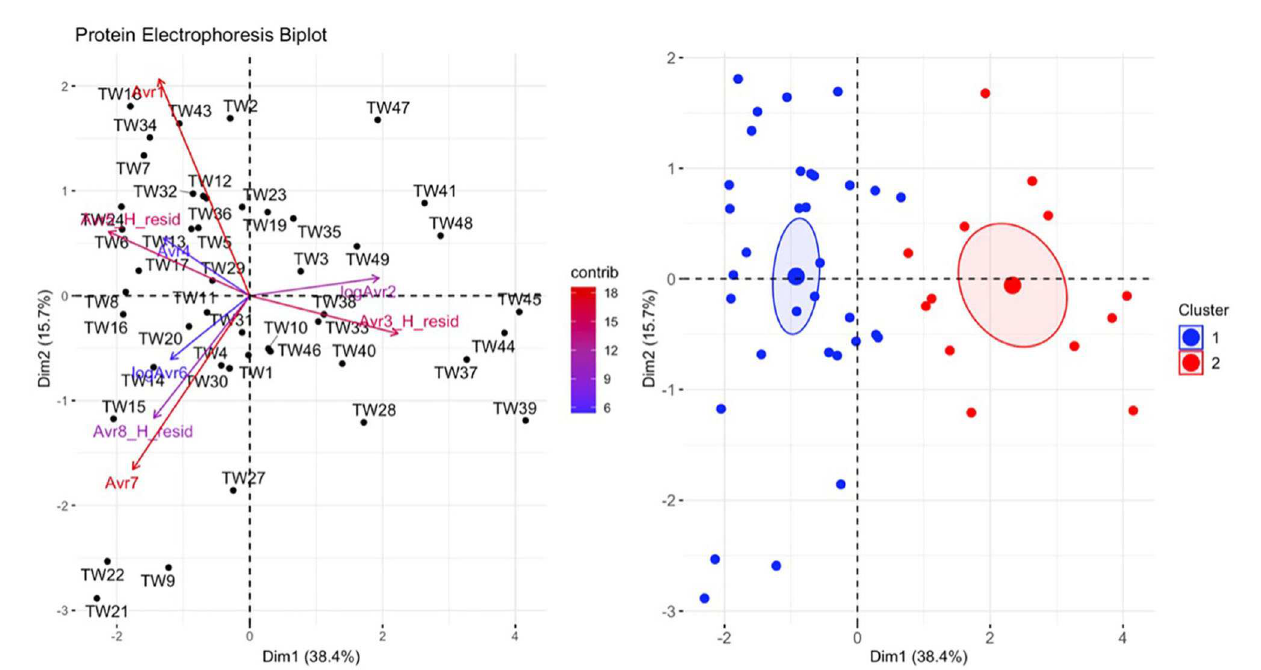
FIGURE10 Principal component analysis (PCA) for the plasma protein electrophoresis data. In the plot on the left, individuals in the same space as the arrowhead had higher values of the blood parameter, and individuals in the opposite direction had lower levels of the blood parameter. The length and color of each arrow represent the strength of the relationship. The plot on the right is showing how the individuals clustered together using K means clustering. The majority of Taricha granulosa in cluster 1 (blue) were controls or Batrachochytrium salamandrivorans (Bsal) infected, non-clinically diseased individuals, and the majority of T. granulosa in cluster 2 (red) were Bsal -infected, clinically diseased